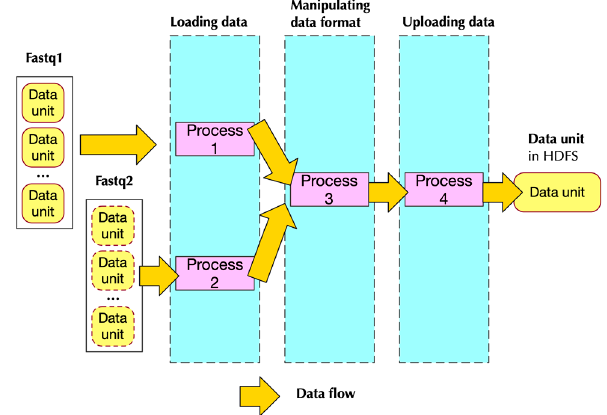
Figure 5. Implementation of the pre-processing stage in the paired-end situation. Process 1 and process 2 are in charge of loading data, each one handling one fastq file. They pass the input data to process 3, which is in charge of manipulating data format. Process 3 passes the result to process 4. Process 4 would upload this data to HDFS.